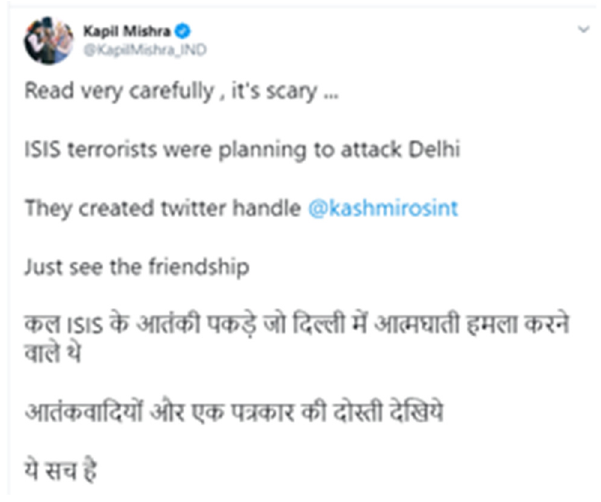
Figure 7. BJP leader Kapil Mishra’s tweet with false information on IS terrorists planning a suicide attack in Delhi.